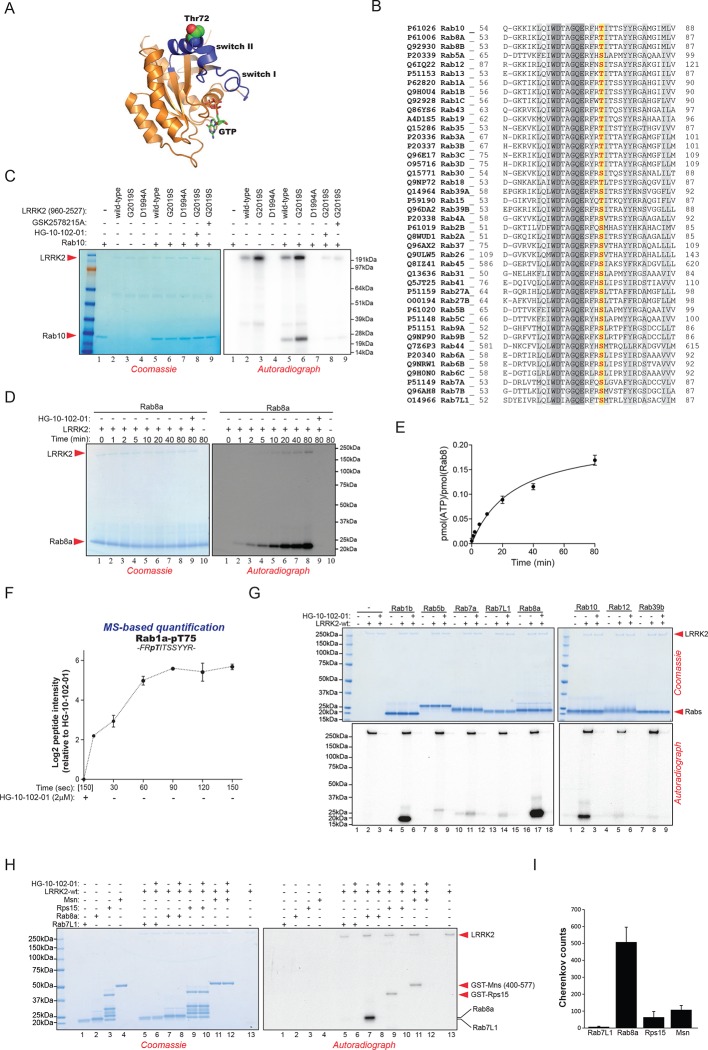
Phosphorylation of Rab GTPases by LRRK2 in vitro.(A) Position of threonine 72 in the switch II region of Rab8a (PDB: 4HLY). (B) Sequence alignment of Rab10 and other indicated Rab-family members. (C) Phosphorylation of Rab10 (1 µM) by wt-, G2019S- or kinase inactive LRRK2-D1994A. Inhibition of LRRK2-G2019S by GSK2578215A or HG-10-102-01 prevents phosphorylation. (D) Time course of LRRK2 (wt) mediated Rab8a (4 µM) phosphorylation and (E) quantification of phosphorylation stoichiometry (n=3). (F) Time course of LRRK2-wt-mediated pT75-Rab1a phosphorylation and MS-based label-free quantification (n=3). (G) In vitro phosphorylation of recombinant Rab proteins (4 µM) by LRRK2-wt. (H) Phosphorylation of recombinant Rab7L1, Rab8a, moesin, and Rps15 by LRRK2 and (I) quantification of the signals. For all reactions LRRK2 inhibitors= 2 µM and LRRK2= 100 ng. Error bars indicate mean ± SEM of replicates. MS, mass spectrometry; SEM, standard error of the mean; wt, wild type.